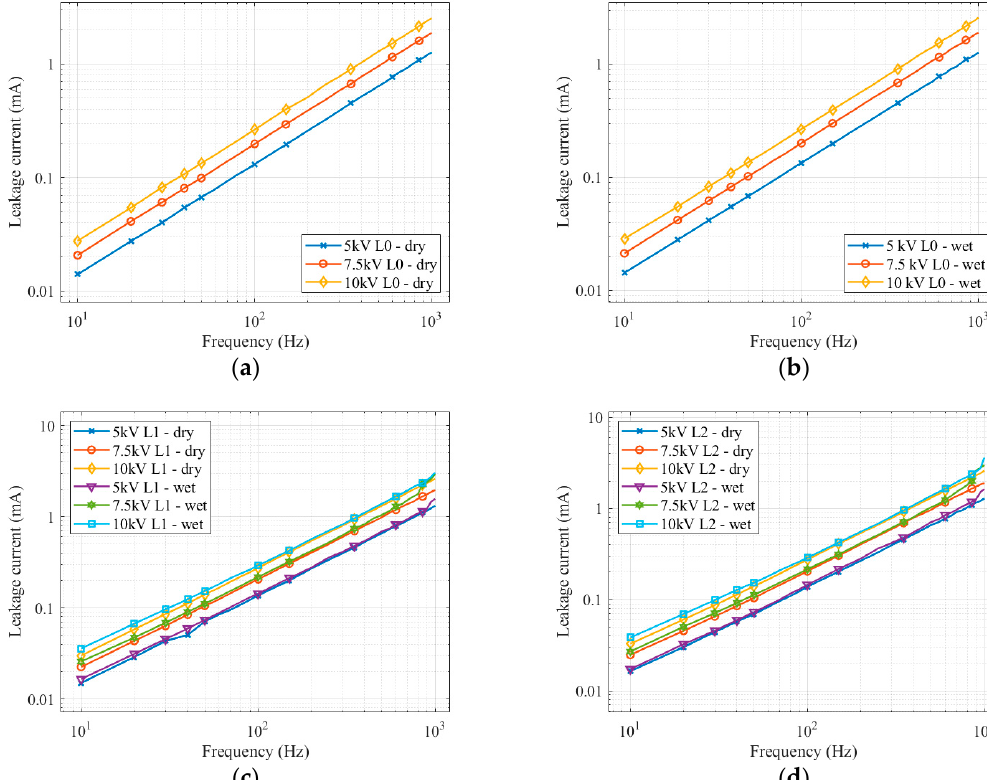
Figure 8. Leakage current frequency spectrum for different voltage levels: ( a ) clean insulator (dry); ( b ) clean insulator (wet); ( c ) first pollution level; ( d ) second pollution level. Table 5. Comparison of differences in leakage current for various voltage